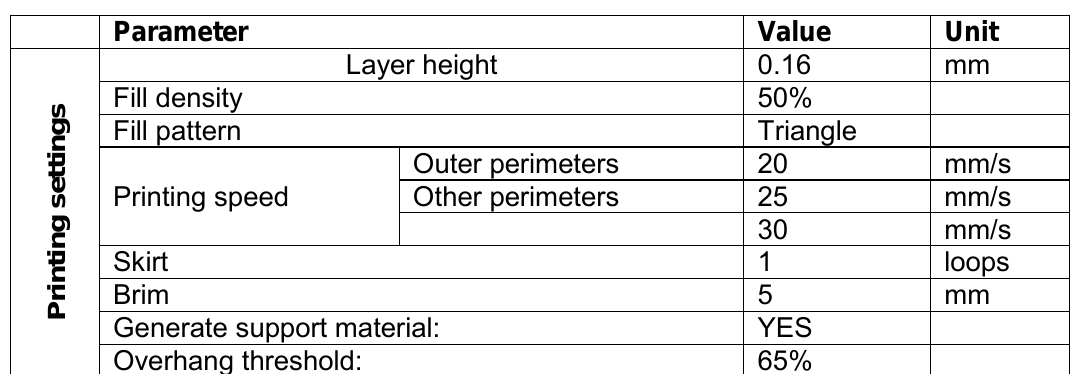
Table 1. Printing parameters.